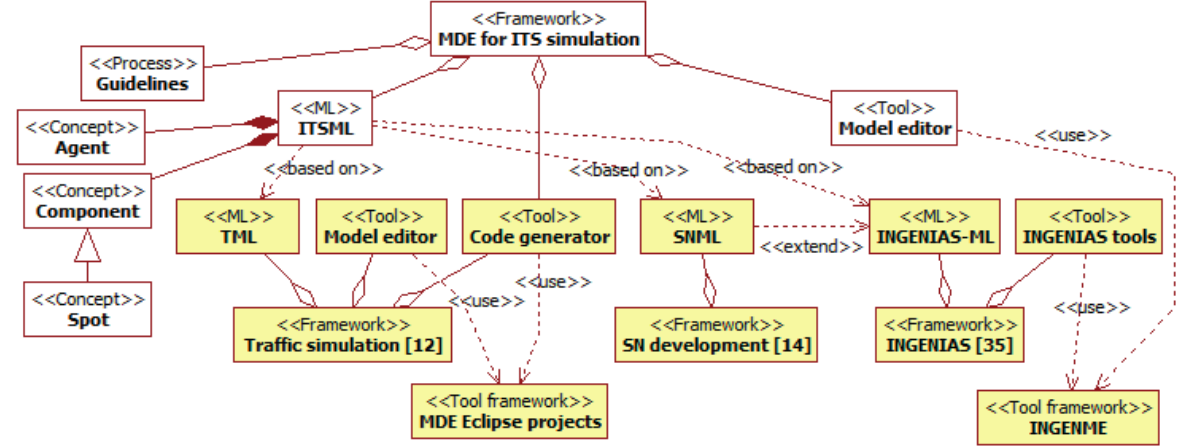
Figure 1. Main components of the Model-Driven Engineering (MDE) framework for Intelligent Transportation System (ITS) simulation (in white) and related works (in yellow). Aggregation relationships (with diamonds) represent whole-part relations, and dependency relationships (discontinuous lines) different relations of